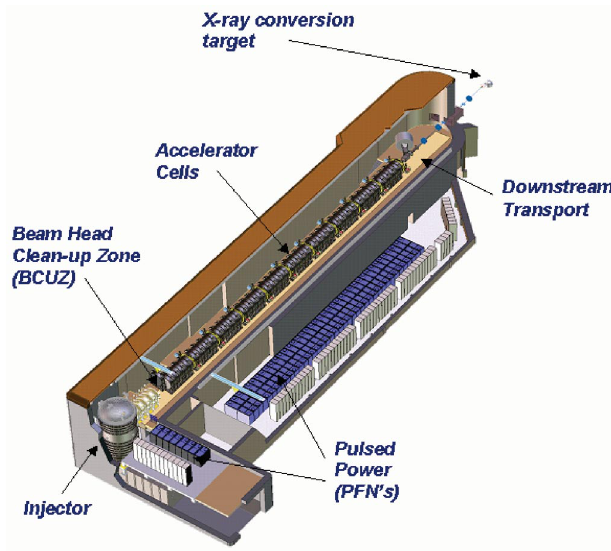
FIG. 24. (Color) Schematic of the DARHT second-axis accel- erator, showing the layout of the injector, beam head clean-up zone, accelerator cells, and downstream transport. Fig. 25. The commissioning geometry is slightly different than the upstream geometry for the final accelerator con- figuration, because additional solenoids are installed in the axial region from 9 to 12.5 m for better matching into the injector commissioning diagnostics. The beam energy grows from 2.6 MeV to 4.0 MeV in this section, with a